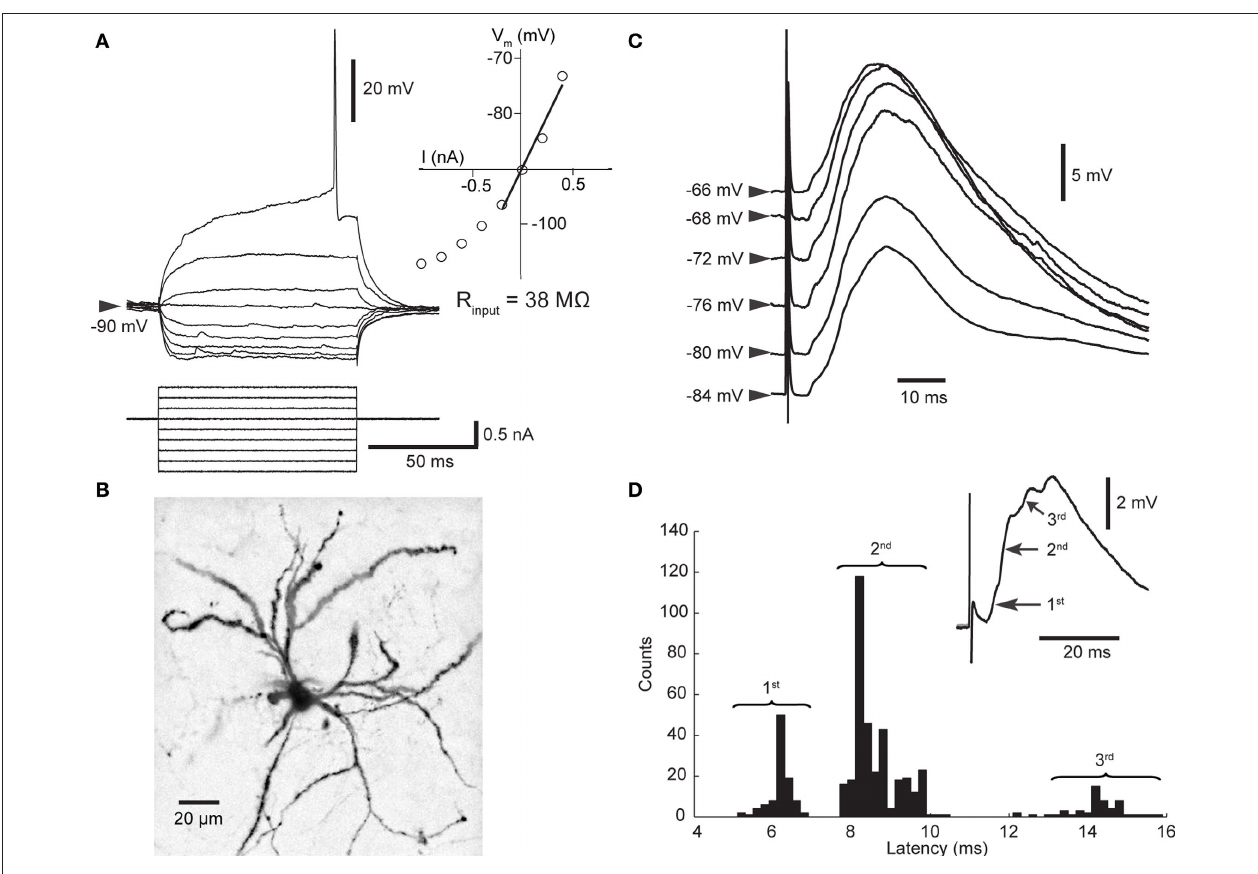
sorted according to initial membrane potential and then averaged. Note the decreased amplitude when cortical stimulation was applied at depolarized membrane potentials. (D) PSPs consisted of several components. Distribution of latencies to maximum slope shows that latencies scattered around three distinct values representing PSP components as indicated in the mean PSP